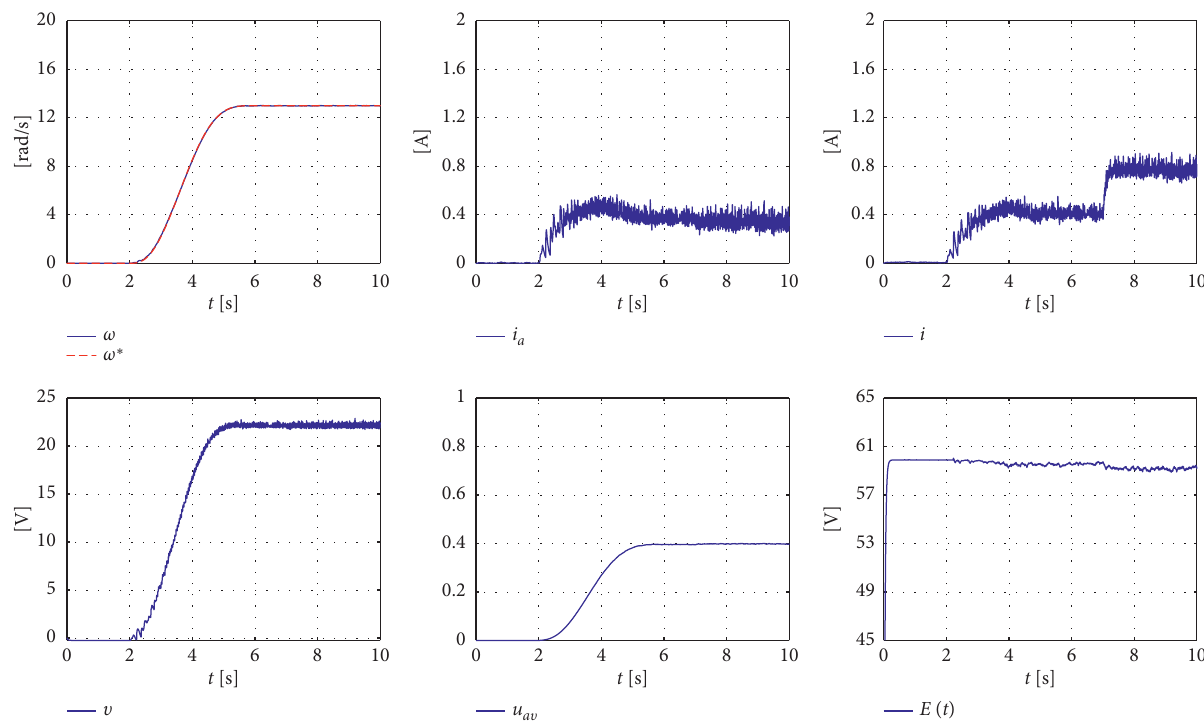
Figure 14: Experimental results of the DC/DC Buck converter-DC motor system in closed loop when E ( t ) is given by equation (25) and carried out through the TDK-Lambda G100-17 power supply via the solar panel TS-S425, and the variations equation (27) are taken into account in R